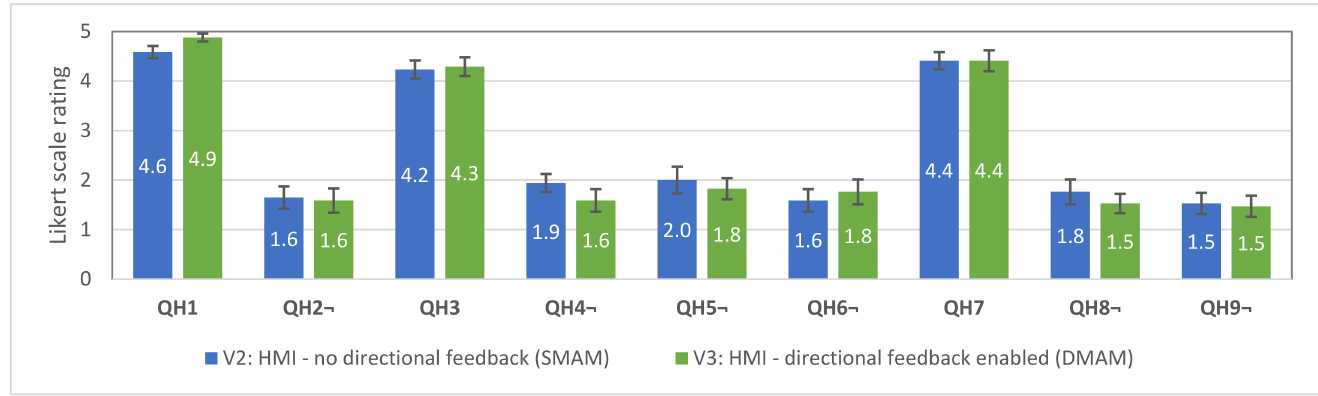
Figure 19. Average scores with standard errors for the questions QH1–QH9 used for evaluation of the HMI usability. Score 5 denotes “totally agree”, and 1—“totally disagree”. Questions QH1, QH3, QH7—higher is better; QH2, QH4, QH5, QH6, QH8, QH9—lower is